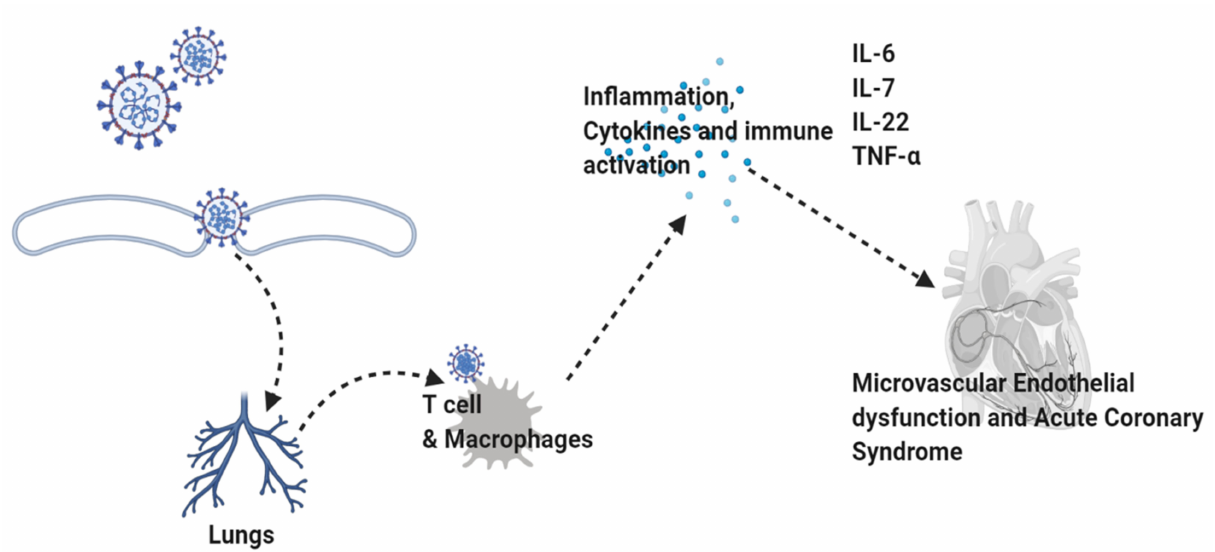
Figure 4. Inflammation in COVID-19. The figure shows the role of macrophages and T cells in the execution of inflammation in COVID-19 and its complications. IL: interleukin; TNF α : tumor necrosis factor